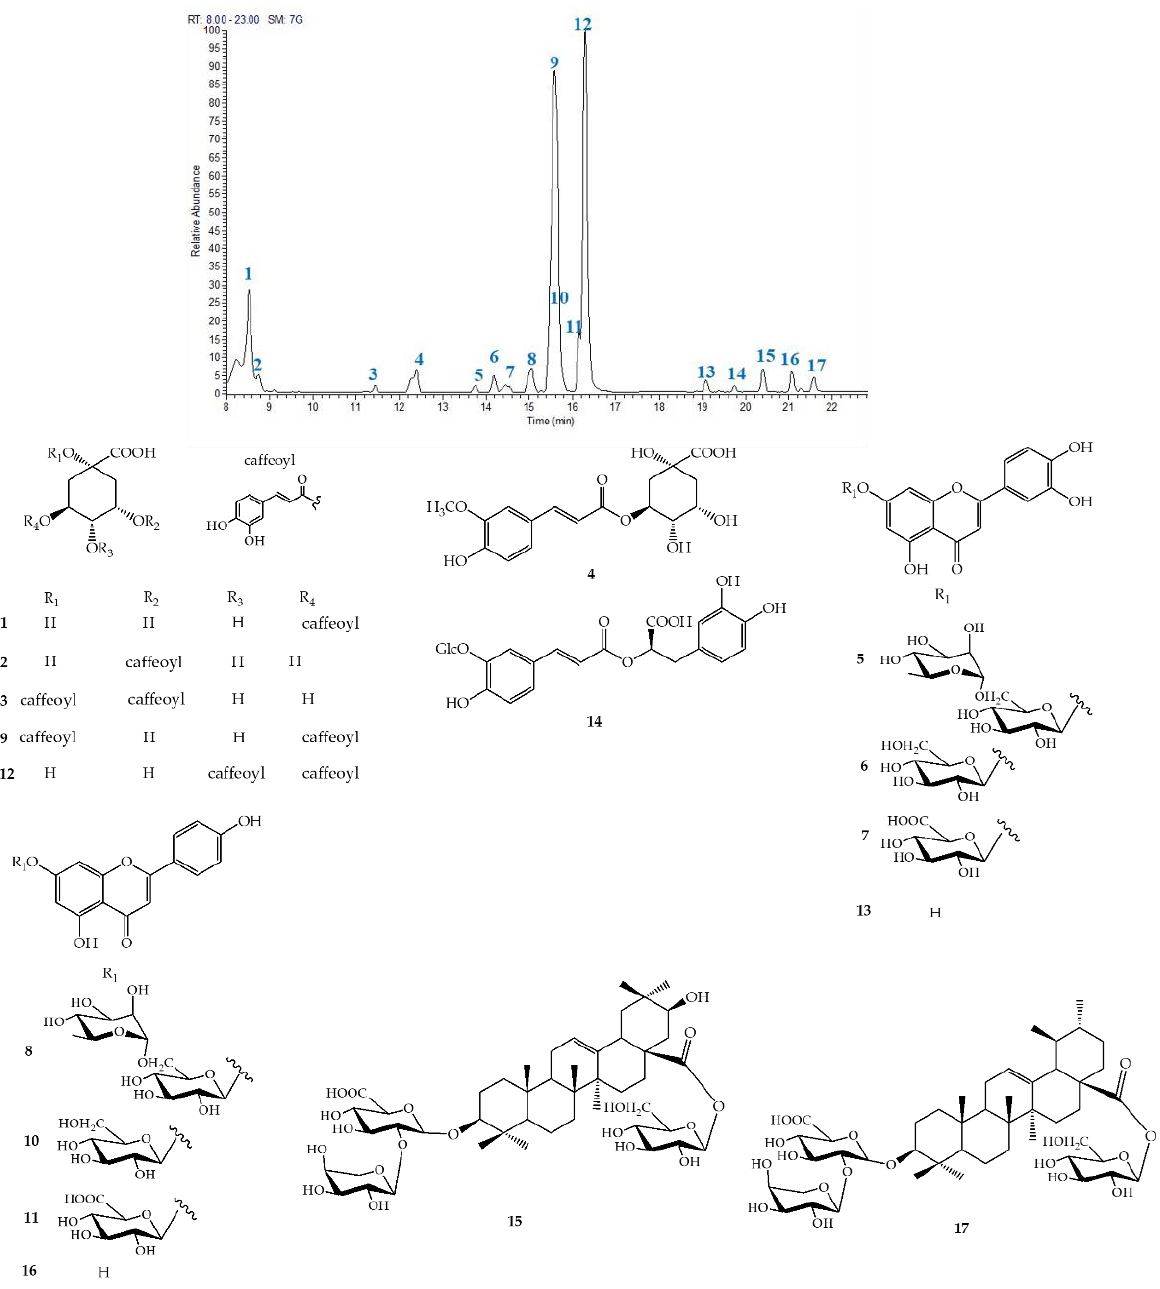
Figure 1. Specialized metabolites isolated from MeOH extract of C. cardunculus subsp. scolymus : cultivar “Carciofo di Paestum” PGI.